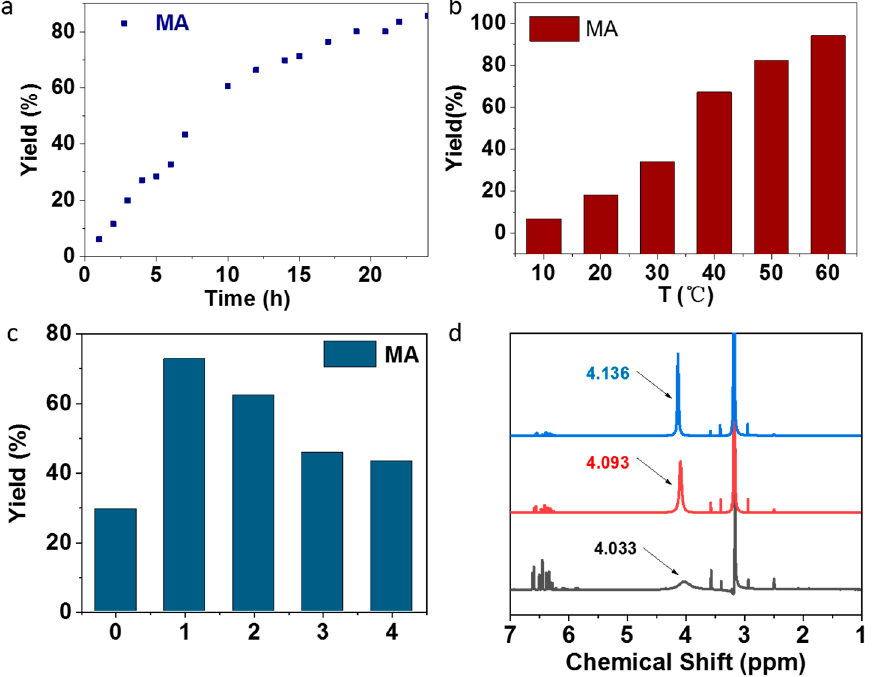
Figure 4. ( a ) Kinetics of the oxidation of acrolein by H 2 O 2 in methanol catalyzed by oxidized Se-1-D-5-40 (Table S1 in the Supporting Information) at 50 ◦ C for 12 h. ( b ) Oxidation of acrolein catalyzed by oxidized Se-2-D-1-40 (Table S1 in the Supporting Information) at different temperatures for 12 h. ( c ) Oxidation of acrolein catalyzed by the series of oxidized selenium-containing DSe-PS. (0: no catalyst; 1: Se-1-D-1-40, 2: Se-1-D-2-40, 3: Se-1-D-3-40, 4: Se-1-D-4-40). ( d ) 1 H NMR spectra of pentafluorophenyl seleninic acid and different amounts of methanol in DMSO- d 6 (blue-0.01 g pentafluorophenyl seleninic acid and 0.21 mL methanol, red-0.01 g pentafluorophenyl seleninic acid and 0.11 mL methanol, black-0.01 g pentafluorophenyl seleninic acid and 0.01 mL